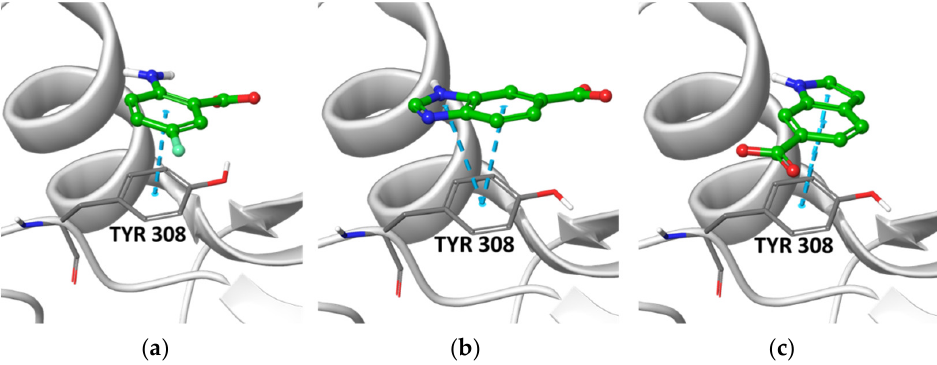
Figure 3. Best poses of representative structures of the three chemotypes selected for experimental validation. ( a ) aminobenzoic acid A3 docked in the Hip312 grid; ( b ) Benzimidazole B2 docked in the His312 grid; ( c ) indole I1 docked in the His312 grid. Fragments are shown as balls and sticks with green carbon atoms. The protein is shown in grey, with the side chain of Tyr308 highlighted.